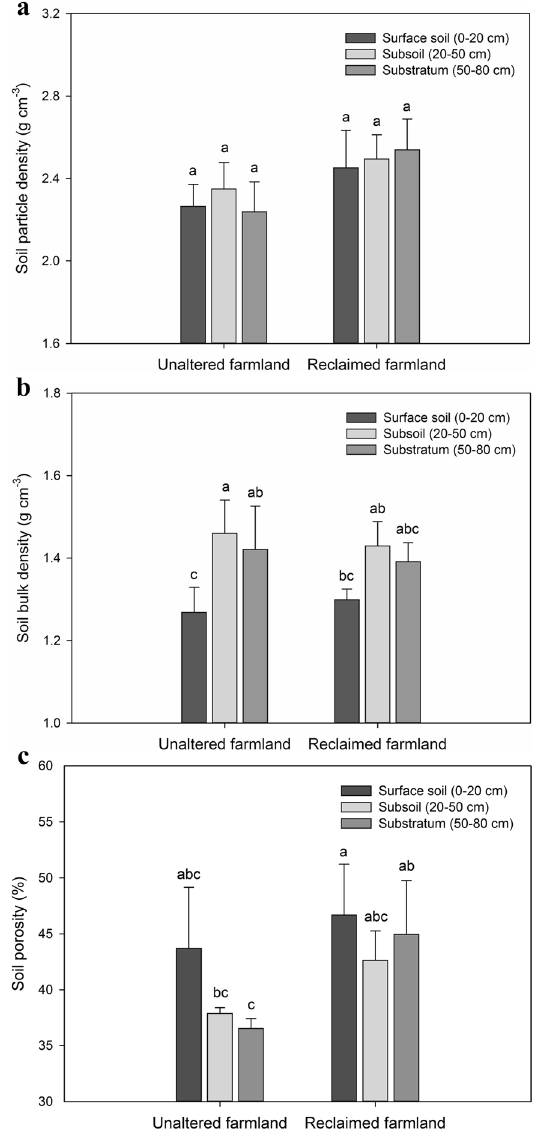
Fig. 2 Soil particle density, bulk density and porosity of the reclaimed and unaltered farmlands. The means with the different letters in the same columns are significantly different at the 0.05 level. a Soil particle density, b soil bulk density, c soil porosity